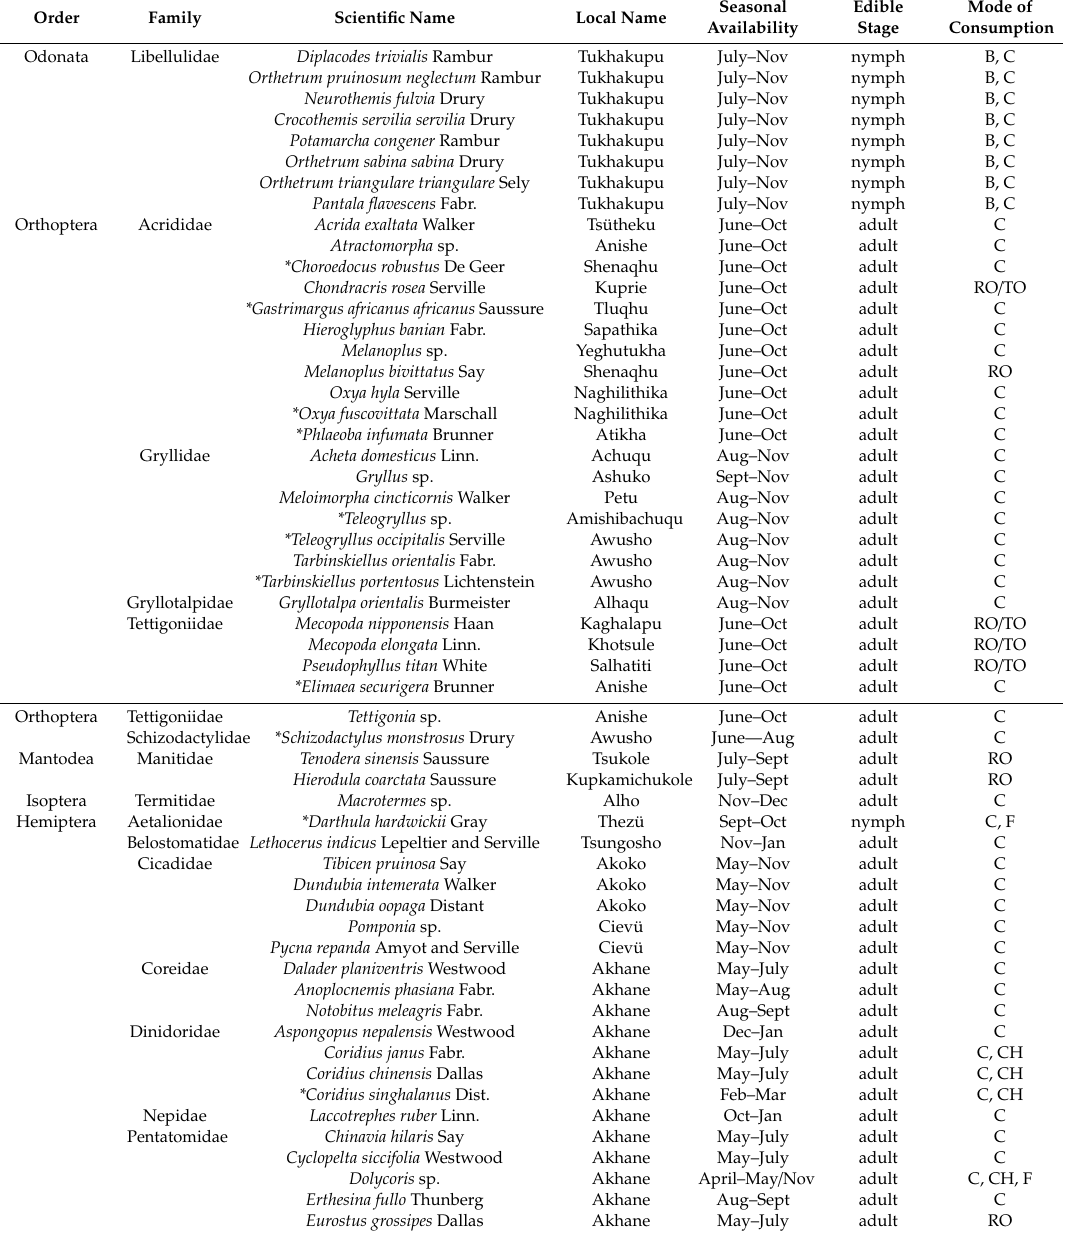
Table 2. Insect species utilized as food by di ff erent ethnic groups in Nagaland (adapted from Mozhui et al., 2017) with new addition of 24 species